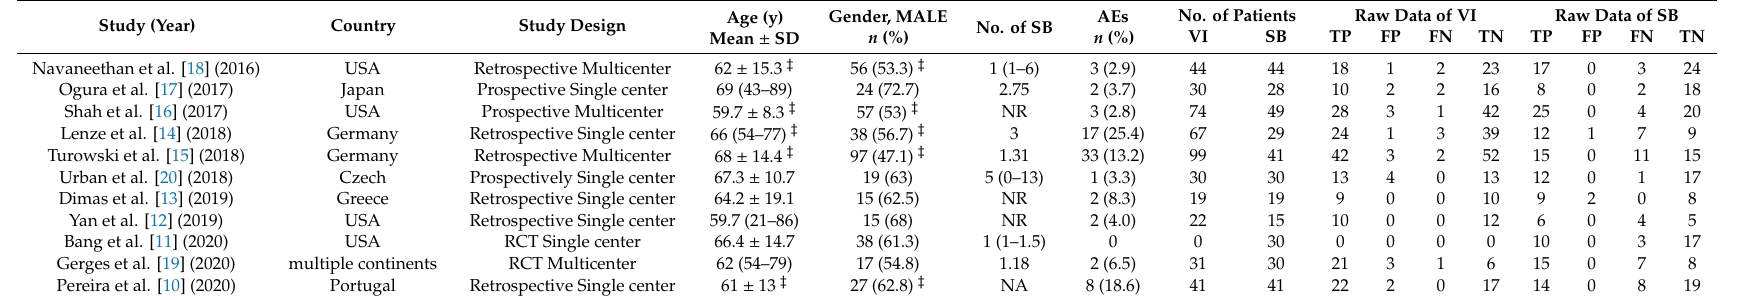
Table 1. The basic characteristics and diagnostic yield of the included studies for VI and